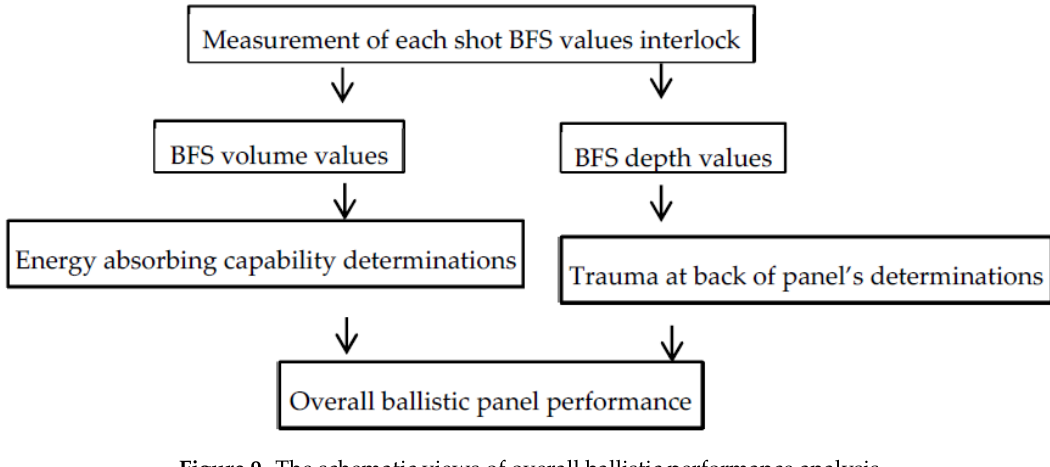
Figure 9. The schematic views of overall ballistic performance analysis.